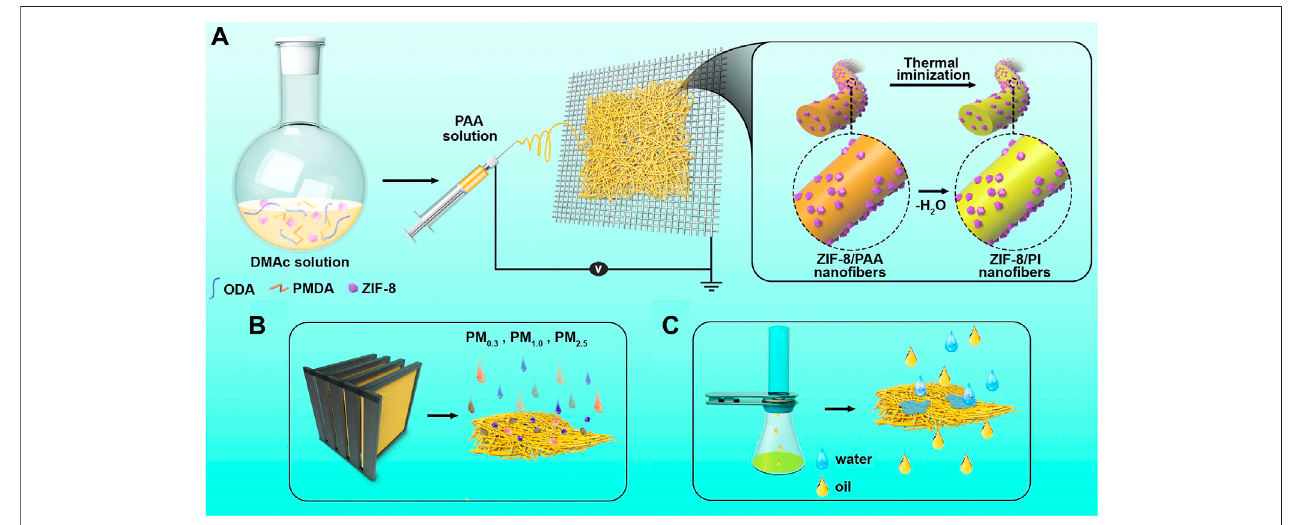
FIGURE 1 | Schematic of the procedure for preparing ZIF-8/PI electrospun nano fi ber membranes and their applications. (A) Schematic of the membranes prepared by the two-step electrospinning method. (B) Air fi ltration of the membranes. (C) Water – oil separation.